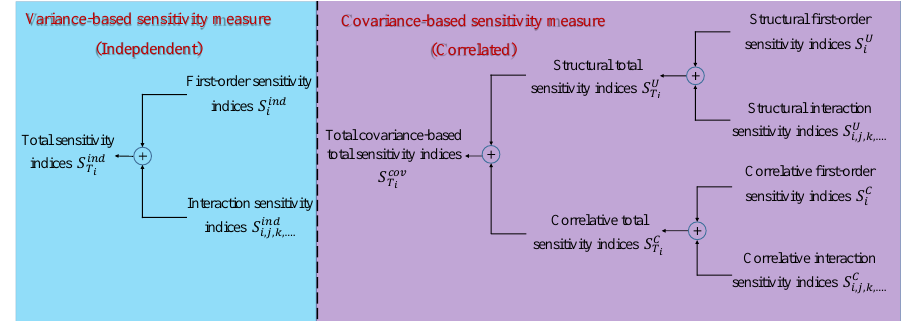
Figure 4. Structure of sensitivity measures for independent (left) and correlated (right)